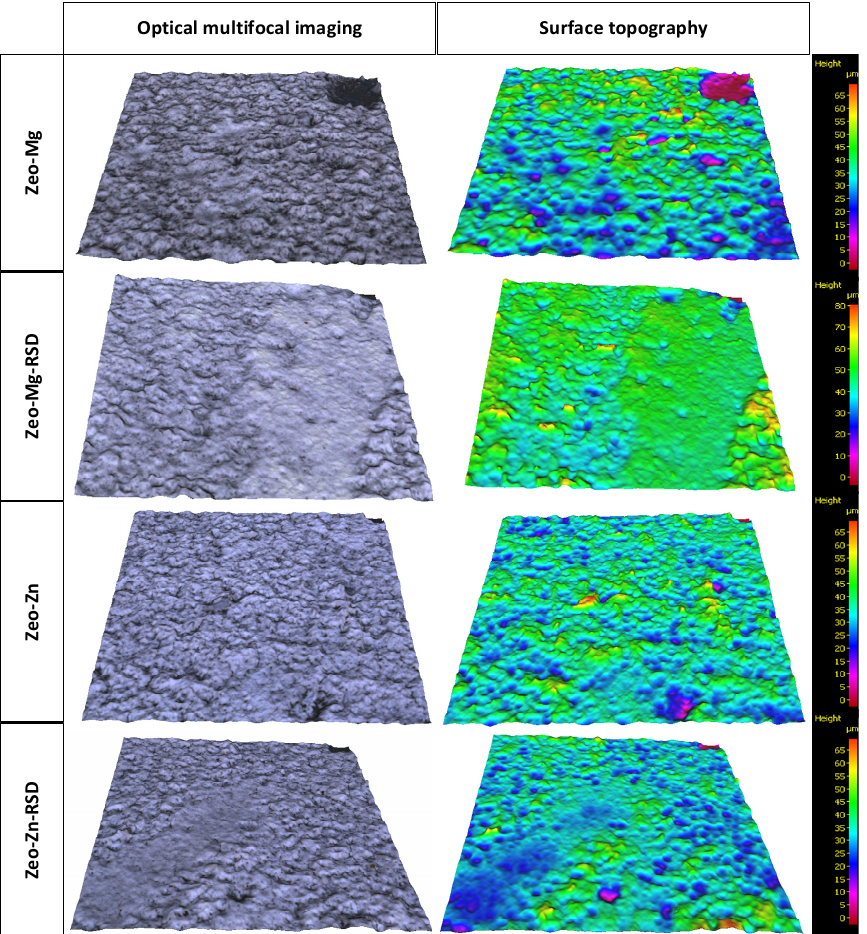
Figure 8. The multifocal images with surface topography of magnesium and zinc zeolite layers before and after drug adsorption (three samples were measured for each material).